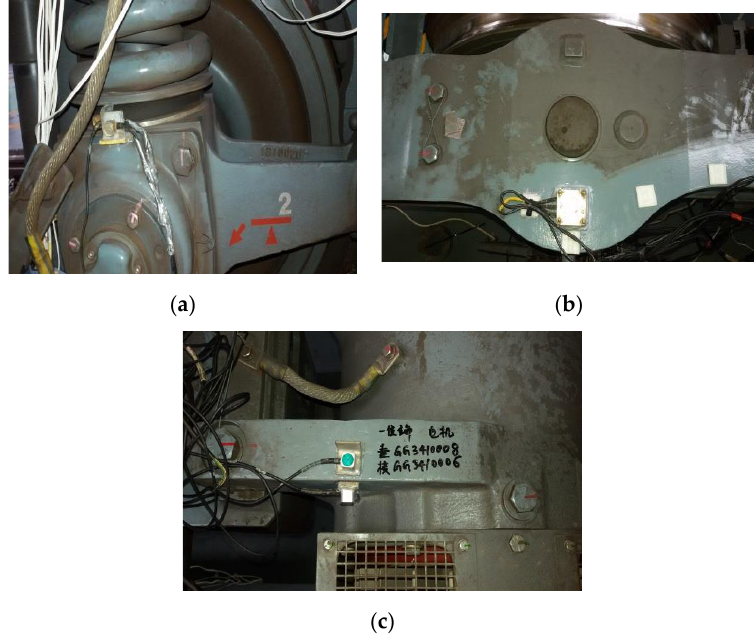
Figure 6. Vibration acceleration tested points: ( a ) sensor on the axle box; ( b ) sensor on the spring sleeve; ( c ) sensor on the motor.